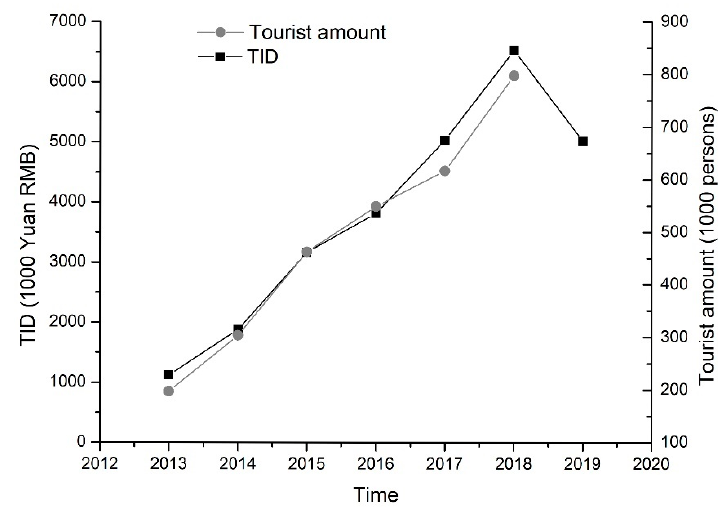
Figure 6. the tourist number and TID change from 2013 to 2019. Figure 6. The tourist number and TID change from 2013 to